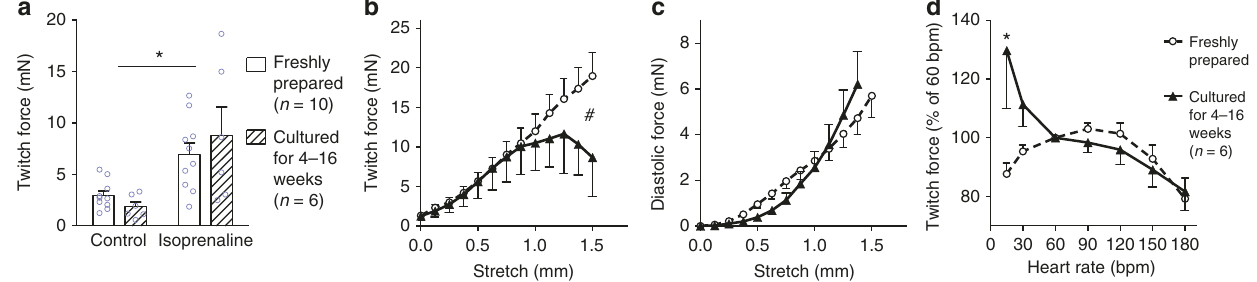
Fig. 3 Biomechanics of myocardial tissue before and after long-term biomimetic cultivation. a Twitch force at 1 mN preload, as determined under isometric conditions in an organ bath in freshly prepared ( n = 10) and cultured tissues ( n = 6) before and after application of isoprenaline (1 µ M) (* P <0.05 control vs. isoprenaline). b – c Response of twitch force ( b ) and diastolic force ( c ) to tissue stretch ( # P <0.05 fresh vs. cultured, n = 10 for fresh tissues, n = 6 for cultured tissues). d Response of twitch force to variation of beating rate ( n = 9 for fresh tissues, n = 6 for cultured tissues, * P <0.05 fresh vs. cultured, bpm = beats per minute). Data are presented as mean ± SEM. Effects were evaluated by two-way ANOVA. Source data are provided as Source Data fi le